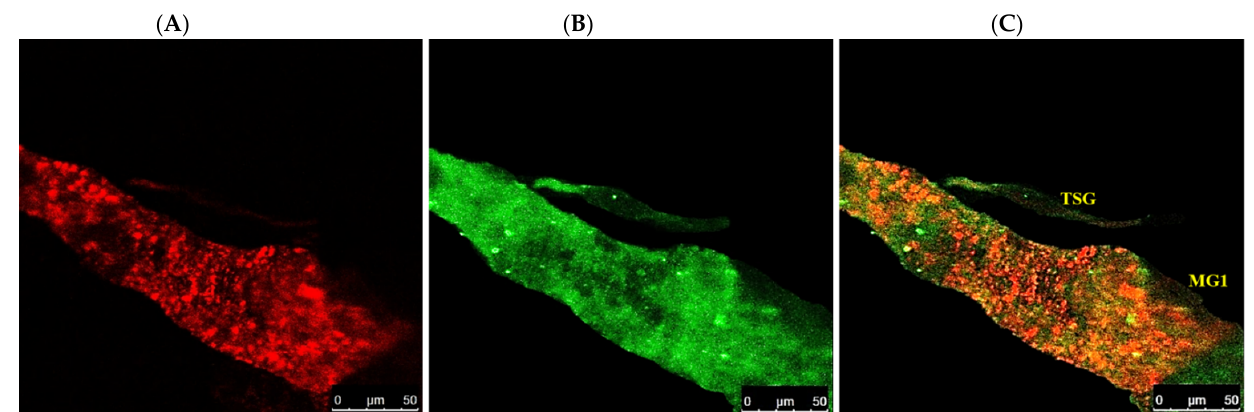
Figure 6. Accumulation of WBNV in ligaments connecting PSG to anterior midgut during P2 stage of Thrips palmi . ( A ). Alexa Fluor 594 phalloidin-conjugated F-actin probe red fluorescence ( B ). FITC-conjugated goat anti-rabbit secondary antibody green fluorescence indicating WBNV-N protein ( C ). Merged image of red and green fluorescence signals. MG1— midgut 1; Lg—ligament. Ligaments connecting midgut to PSG were intact during pupal stages. WBNV infection was detected in ligaments connecting MG1 to PSG.